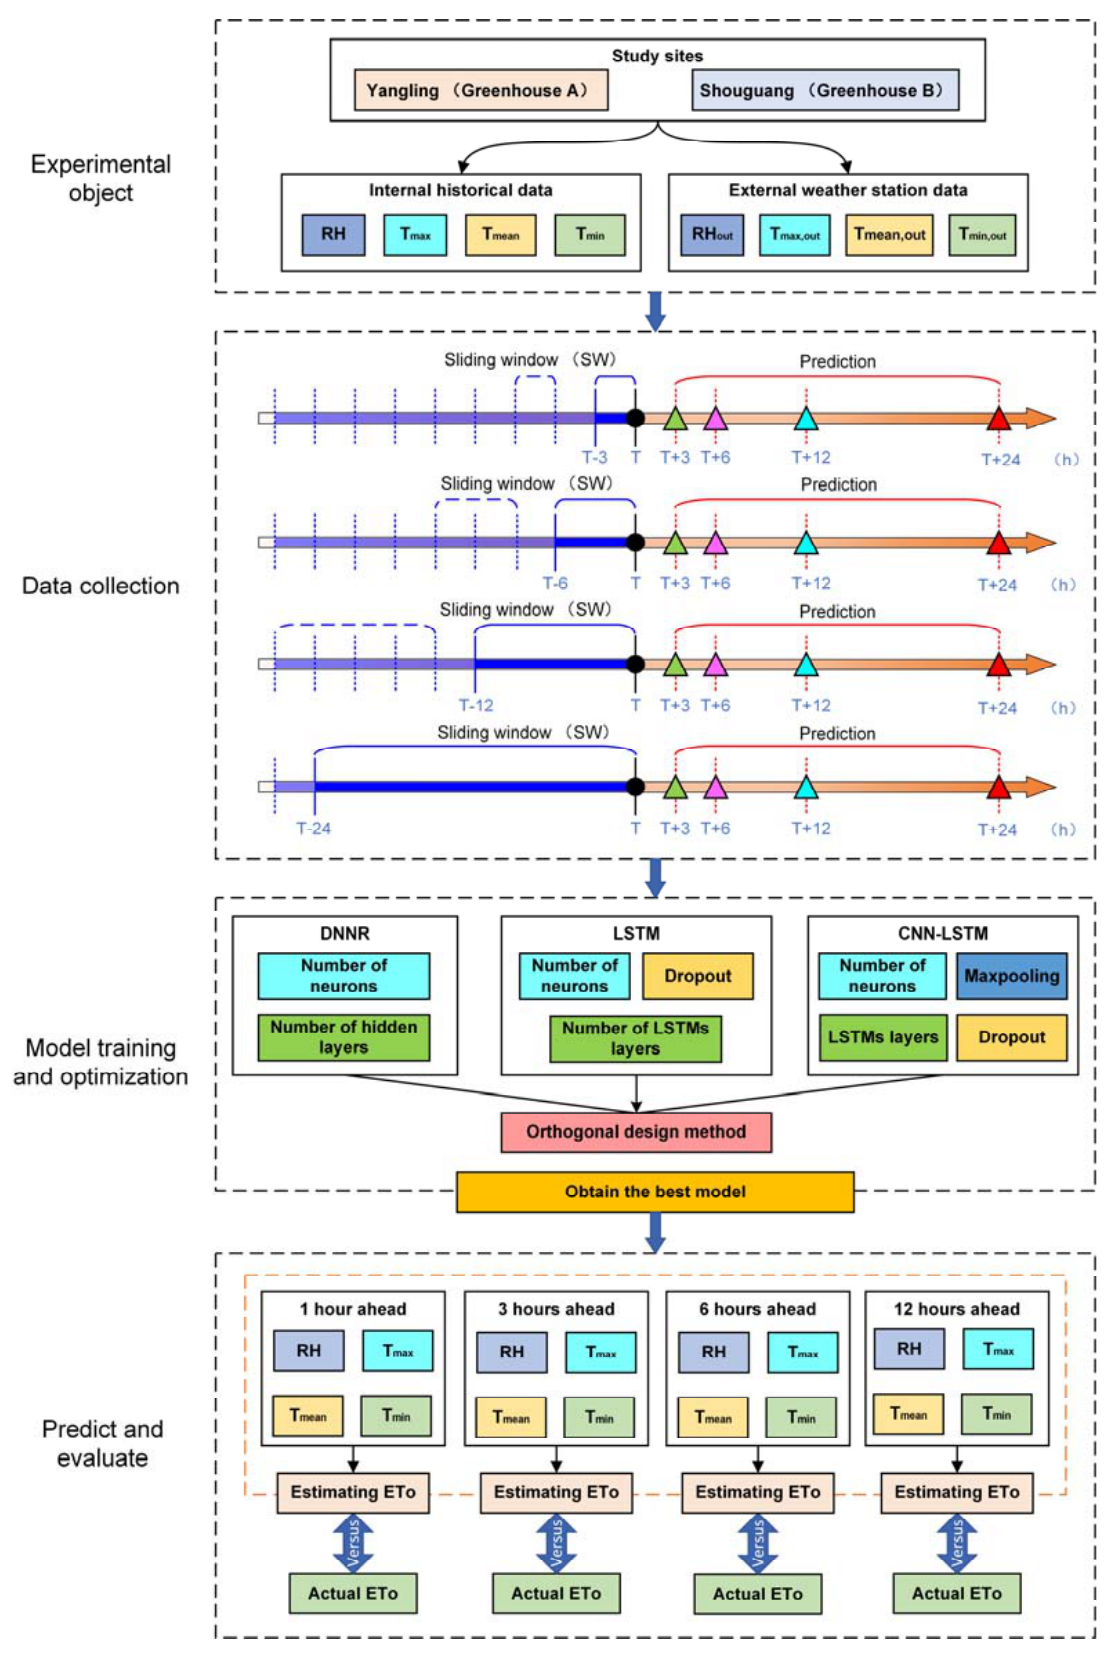
Figure 8. The overview of the research in this paper.